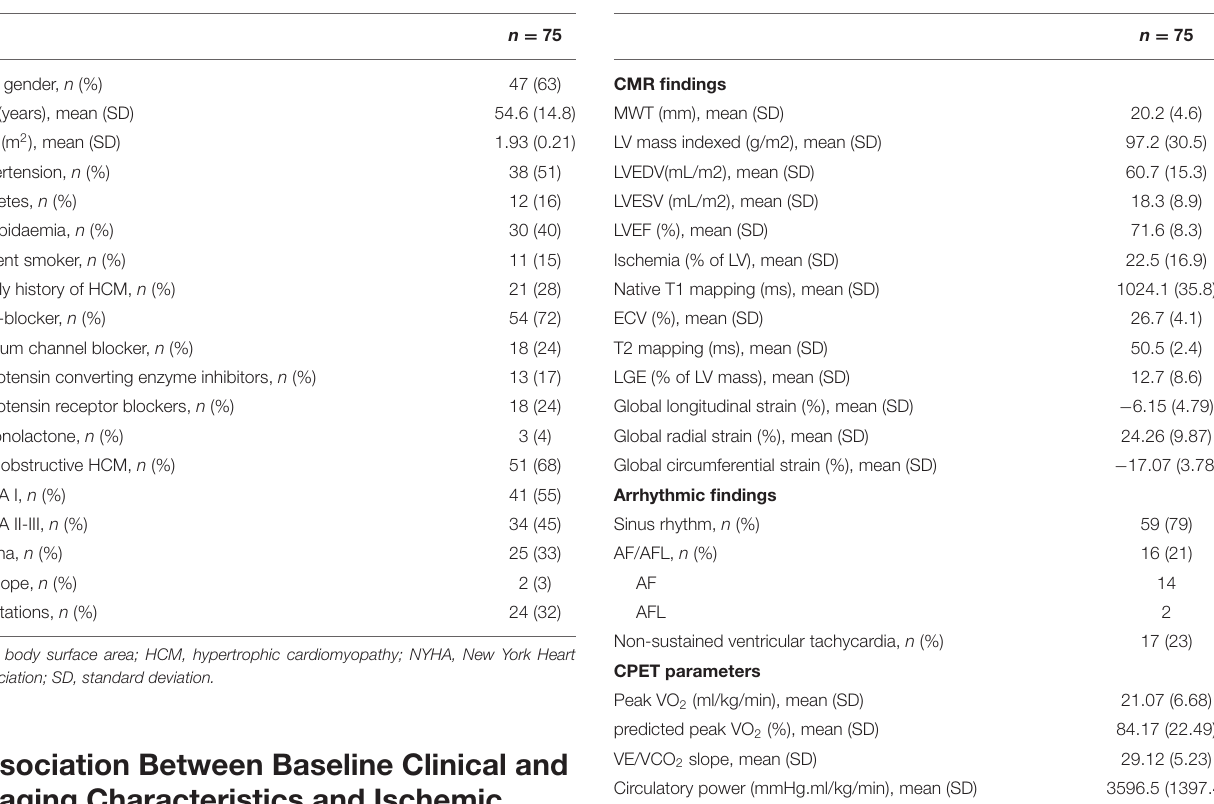
TABLE 1 | Baseline characteristics of the study participants. TABLE 2 | Imaging, arrhythmic, and functional findings.